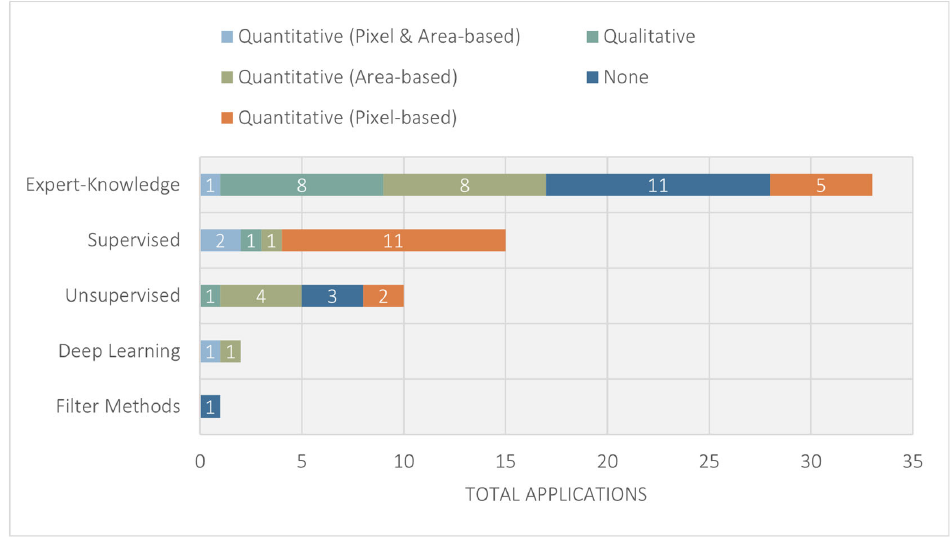
Figure 10. Comparison of the validation methods reported in the selected articles and the applica- tion types.